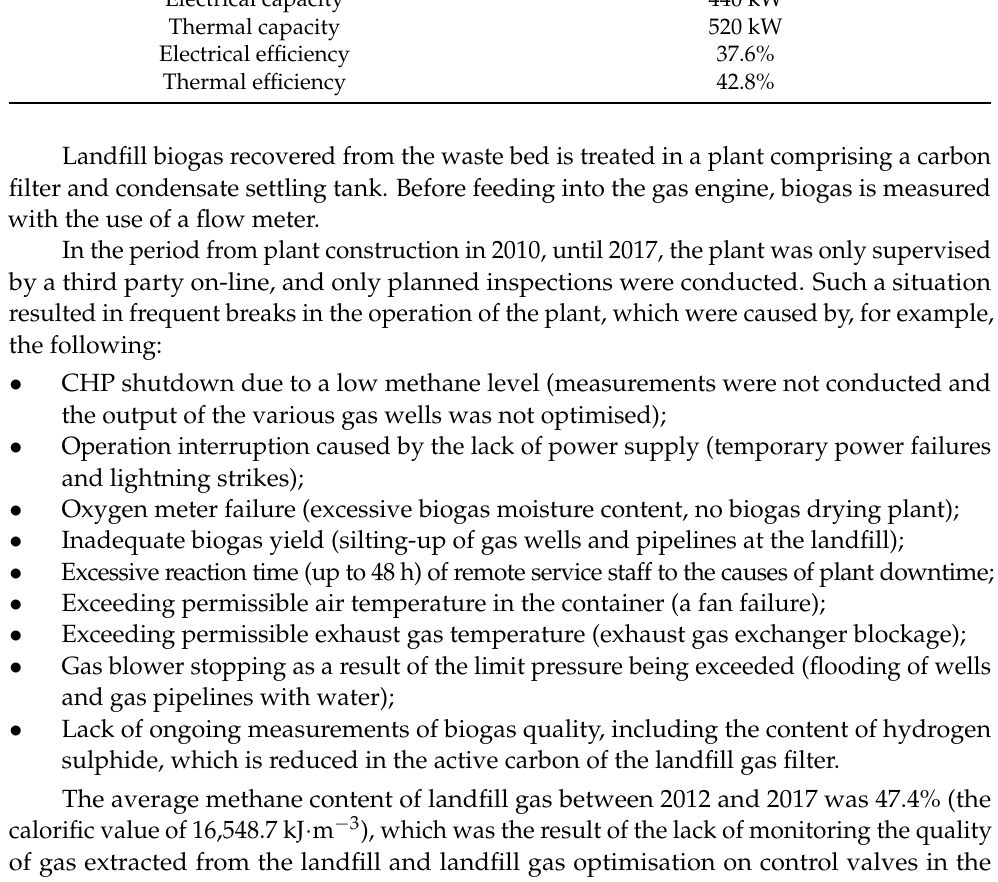
Table 1. Technical parameters of the cogeneration unit. Parameter Value Electrical capacity 440